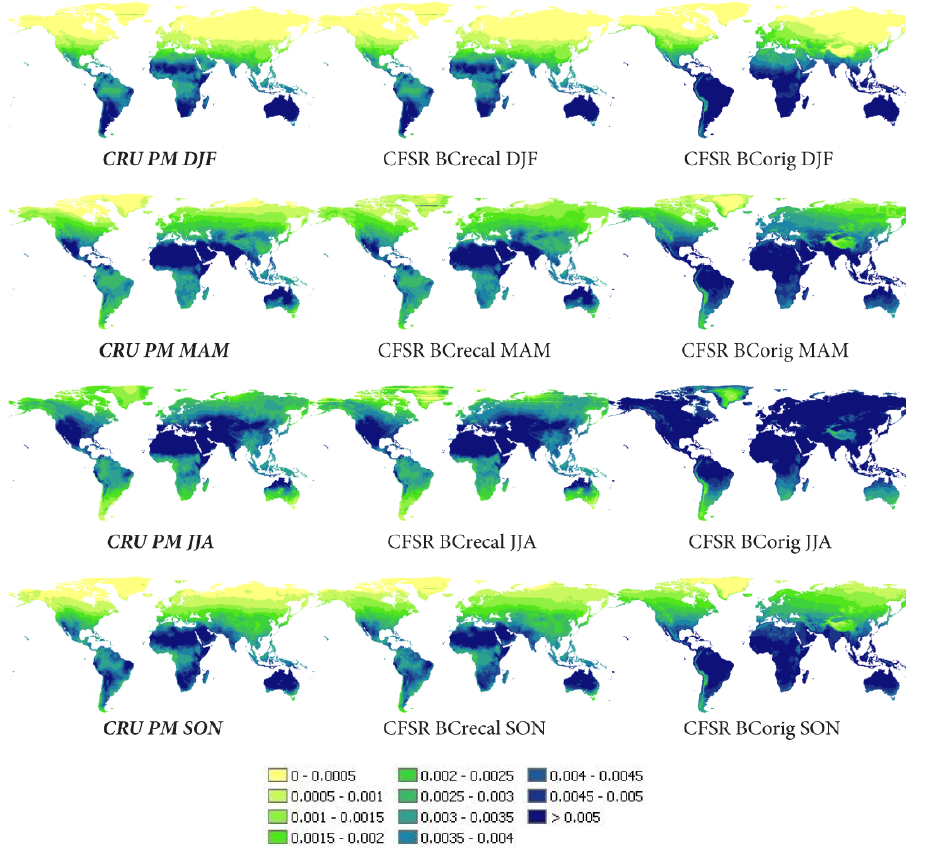
Fig. 4b. Global maps with seasonal average daily potential evaporation (mday − 1 ) . CRU derived with the Penman-Monteith equation (left; =reference for validation), CFSR derived with the re-calibrated Blaney-Criddle equation (middle; BCrecal) and CFSR derived with the original Blaney-Criddle equation (right; BCorig). From top to bottom the DJF, MAM, JJA and SON